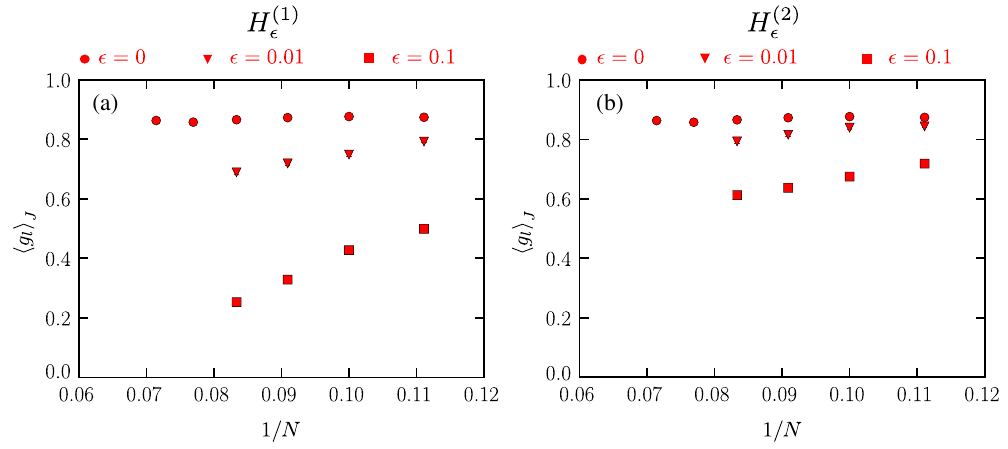
G t → ∞ Þi as a function of the system size N for the l ¼ 3 mode, l i J ¼ h l ð J 1 Þ ð 2 Þ ϵ (left panel) and H ϵ (right panel) from Eqs. (6.3) and (6.4), respectively: are included, but they are smaller than the size of the markers. J t → ∞ Þ vanishes for a l ð